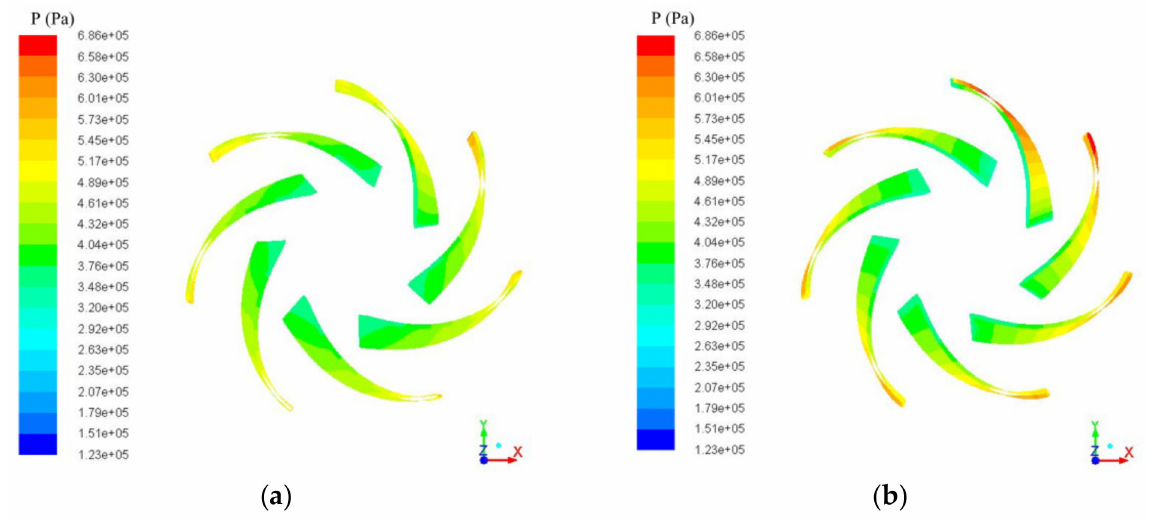
Figure 8. The static pressure distribution at the PAT blade surface under different flow rates: ( a ) Q = 17.25 kg/s; ( b ) Q = 27.6